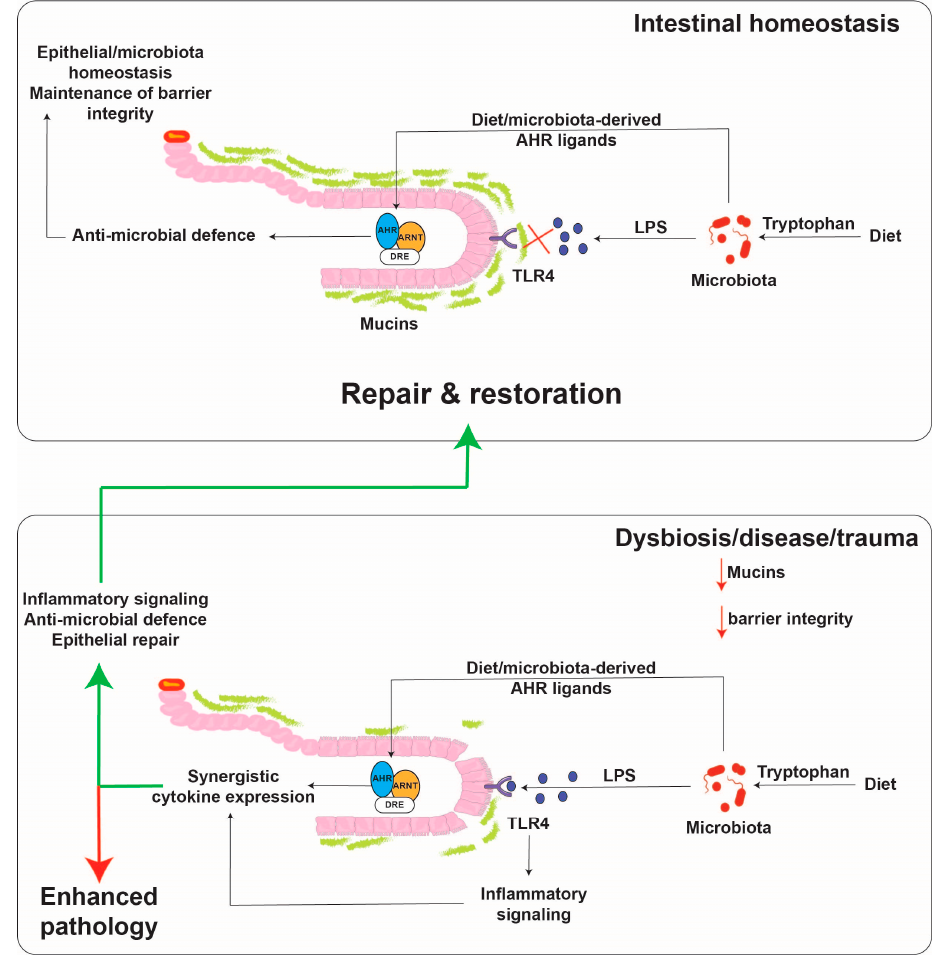
Figure 3. Proposed model for cytokine regulation by the AHR and TLR4 in the intestinal tract. Small molecules are capable of diffusing across the mucus lining and binding to the AHR, while TLR4 ligands, such as lipopolysaccharide as much larger molecules, do not diffuse across the mucus lining except upon a breach. The presence of both activators leads to robust cytokine/chemokine production. The activated AHR then aids in the repair response to the breach.